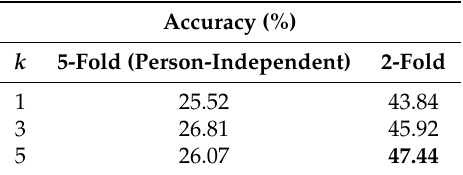
Table 6. Emotion detection accuracy achieved for different k of k -NN for FPGA implementation.